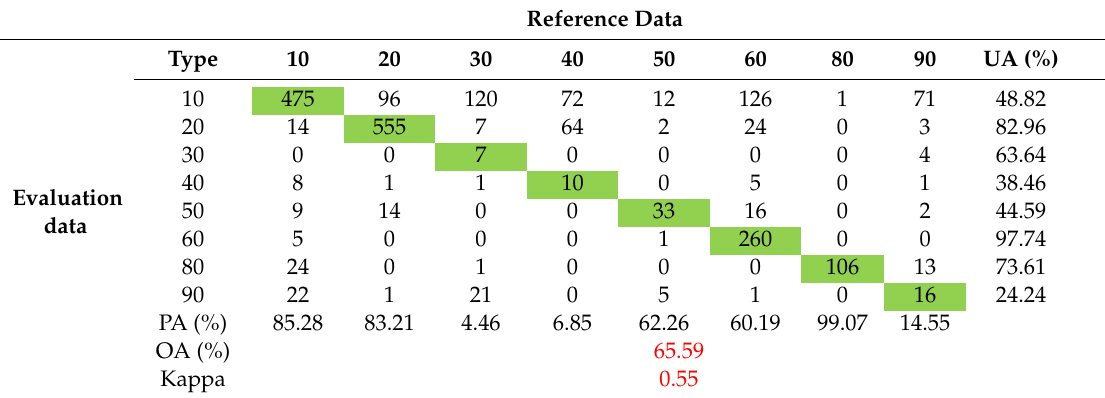
Table 9. GLC_FCS30-2015 confusion matrix.